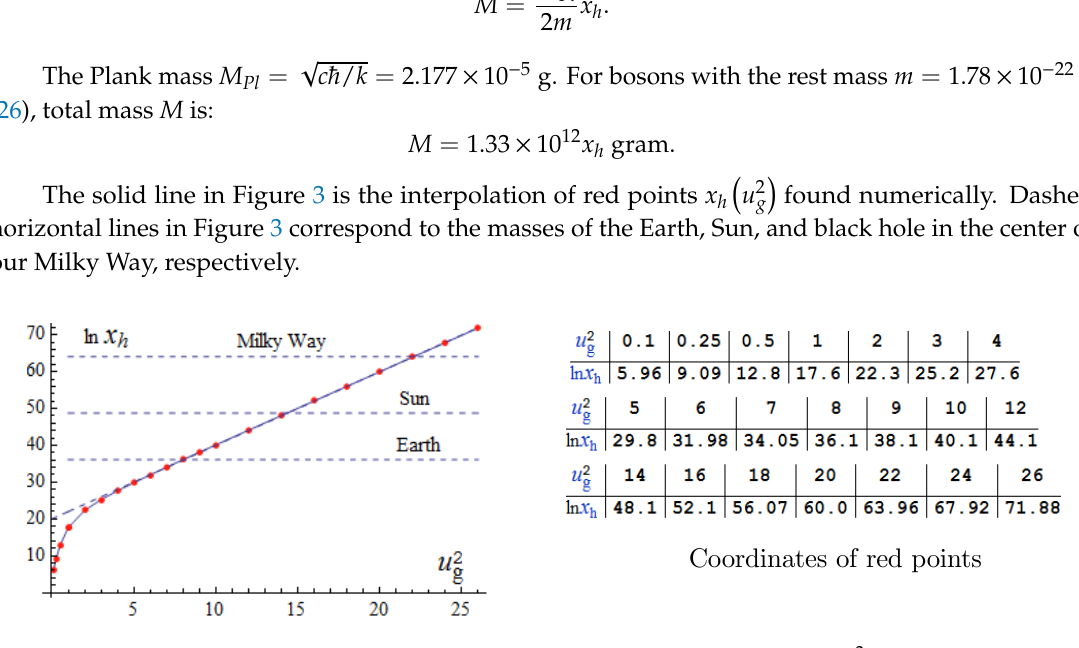
Figure 3. Dependence of the event horizon radius x h on the condensate density u 2 g in dimensionless units. The logarithmic scale is used along the vertical axis. Three dashed horizontal lines correspond to the masses of the Earth, the Sun, and the black hole in the center of the Milky Way, respectfully.